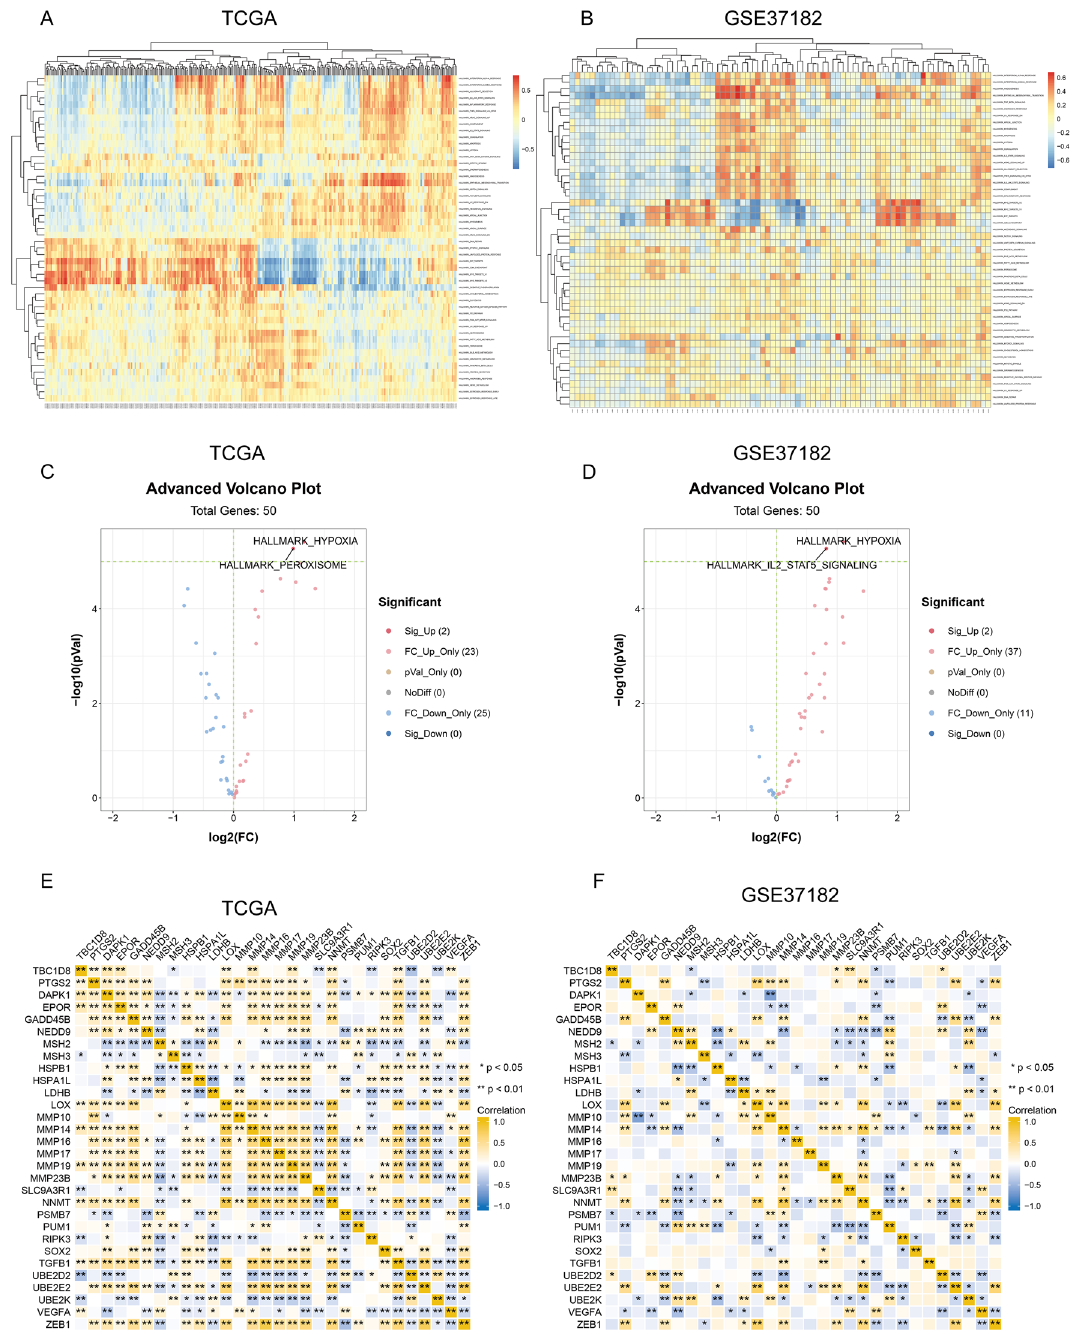
Figure 4. The differentially enriched genesets correlated with TBC1D8 expression were studied through the gene set variation analysis (GSVA) algorithm based on TCGA and Gene Expression Omnibus (GEO) datasets. ( A , B ) Heatmap displaying the hierarchical clustering of enrichment scores obtained through Gene set variation analysis (GSVA) based on the enrichment degree profile of the datasets. ( A ) TCGA; ( B ) GSE37182. ( C , D ) Volcano plot of the differentially enriched genesets in CRC patients with different expression of TBC1D8 in (TCGA) and (GSE37182) dataset was analyzed by GSVA by “limma” R package ( C TCGA, n = 480, D GSE37182, n = 84). Blue nodes indicate downregulation, red indicates upregulation. ( E , F ) Relationship between TBC1D8 and hypoxia-related genes based on TCGA (n = 480) ( E ) and GSE37182 (n = 84) ( F ). Yellow indicates a positive and blue indicates a negative relationship; darker color shows stronger correlation. ( * P < 0.05, ** P <